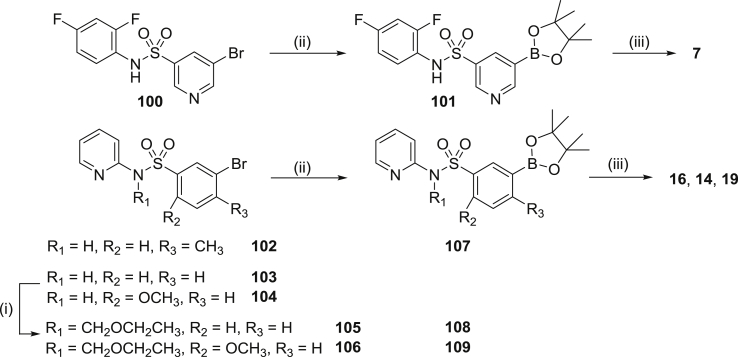
Reagents and conditions: (i) a. NaH, DMF, 0 °C, 0.5 h, b. (Chloromethoxy)ethane, DMF, 0 °C-RT, 1.5 h; (ii) Bis(pinacolato)diboron, KOAc, Pd(dppf)Cl2, DMSO, 90 °C, 3 h.; (iii) a. 75, Pd(dppf)Cl2, EtOH/toluene, 2 M Na2CO3, reflux, b. Deprotection if required: 3 M HCl/1,4-dioxane (1:1), 1 h.